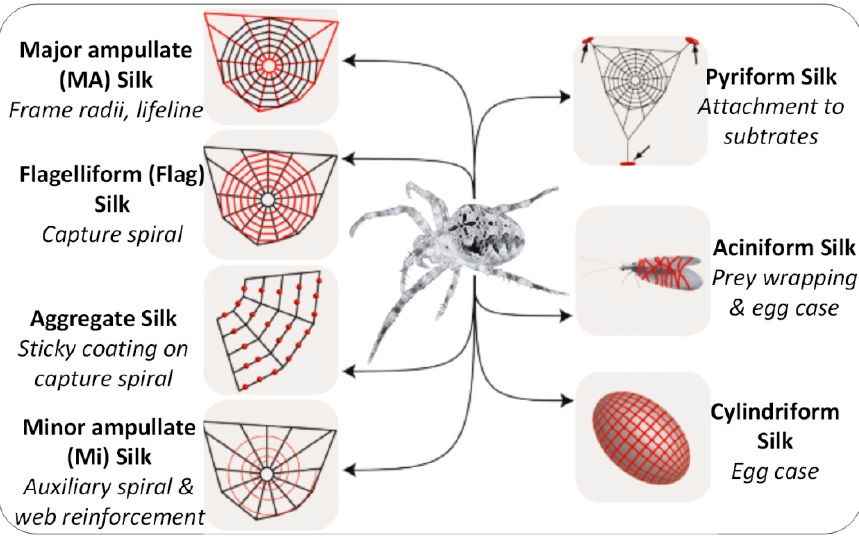
Figure 1. Different design of spider silks and their specific purpose as a web, adapted from